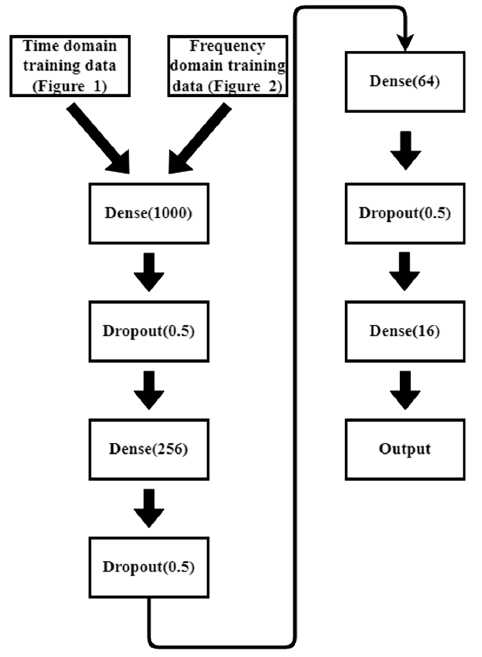
Figure 4. Time and frequency domain two ‐ input NN model (adapted from [10]).